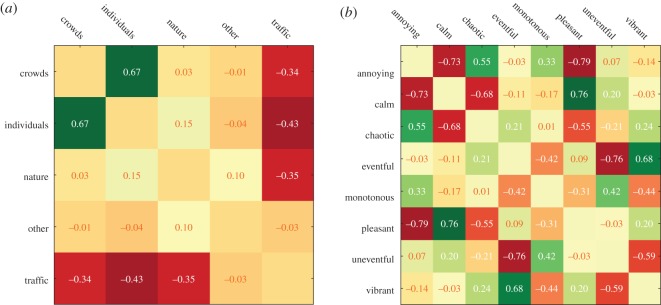
Pairwise rank cross-correlations between the survey's sound scores soundk,c (a) and its perception scores perceptionk,e (b).